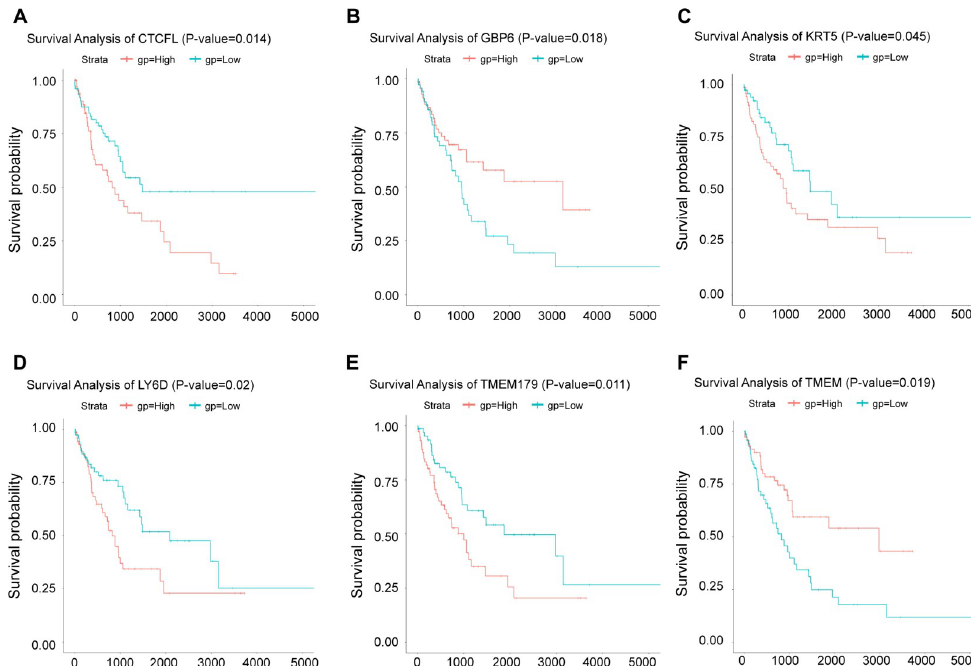
Fig 6. Survival curve of differentially expressed mRNA. A. Survival curve of CTCFL. B. Survival curve of GBP6. C. Survival curve of KRT5. D. Survival curve of LY6D. E. Survival curve of TMEM. F. Survival curve of TMEM179. The abscissa represented survival time (days), and the ordinate represented survival rate. The blue line represented the low risk curve and the red line represents the high risk curve, p < 0.05.